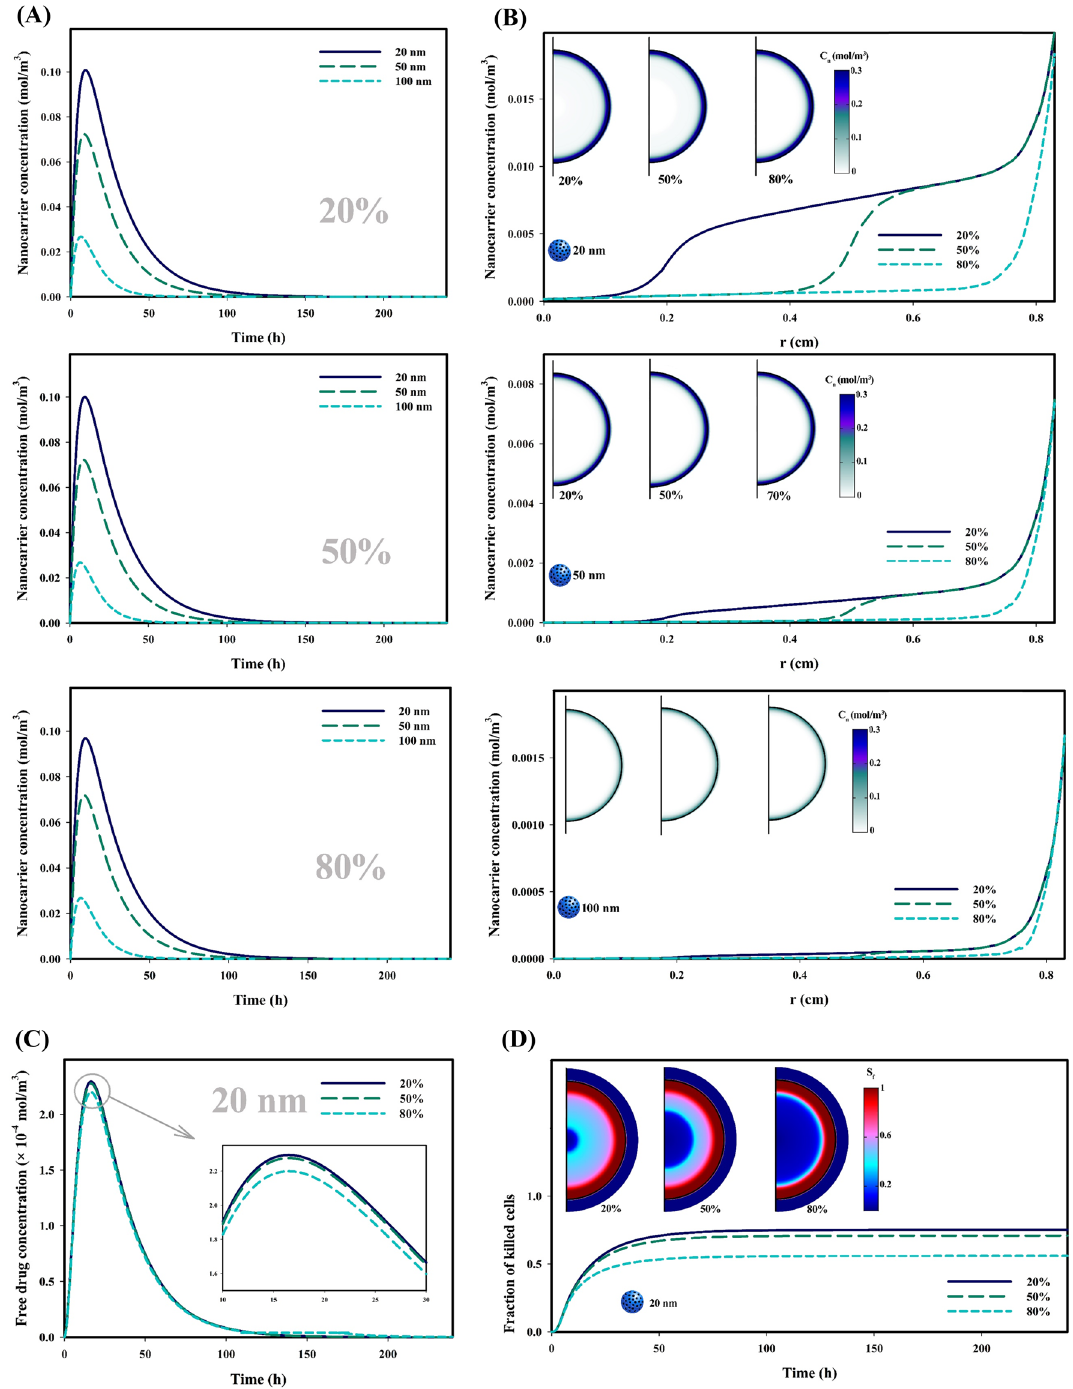
Figure 4. Influence of hypoxic region on the distribution of therapeutic agents and therapeutic response; ( A ) Temporal distribution of responsive nanocarriers in tumor interstitium; Concentration of smaller nanocarriers is higher in tumor tissue, and the increase in the extent of the hypoxic region reduces the concentration, especially for small nanocarriers, ( B ) Spatial distribution of responsive nanocarriers in tumor interstitium; The highest concentration of nanocarriers is in the periphery of the tumor, while the hypoxic regions have the lowest concentration due to poor perfusion, ( C ) Temporal distribution of drug released from nanocarriers (20 nm) in tumor interstitium; Weaker accumulation of nanocarriers in tumors involving larger hypoxic regions, results in lower concentrations of free drug, ( D ) Fraction of killed tumor cells over time; Due to the fact that the concentration of the free drug in hypoxia areas is very low, so the cells in these areas do not suffer from death due to anti-cancer drug. ( C n : Nanocarrier concentration, S f : fraction of killed